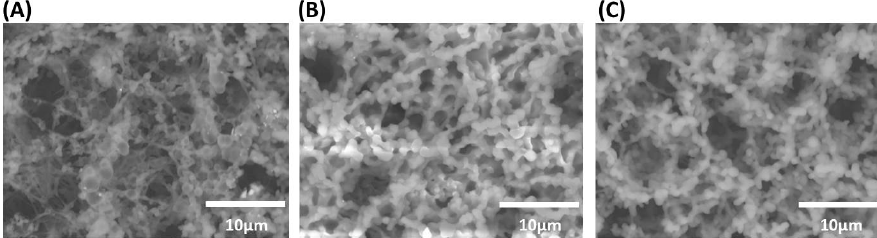
Figure 2. Scanning electron microscopy images of nitrocellulose membrane. ( A ) Without Nafion coating; ( B ) With Nafion coating (type I, without heating); ( C ) With Nafion coating (type II, with heating).